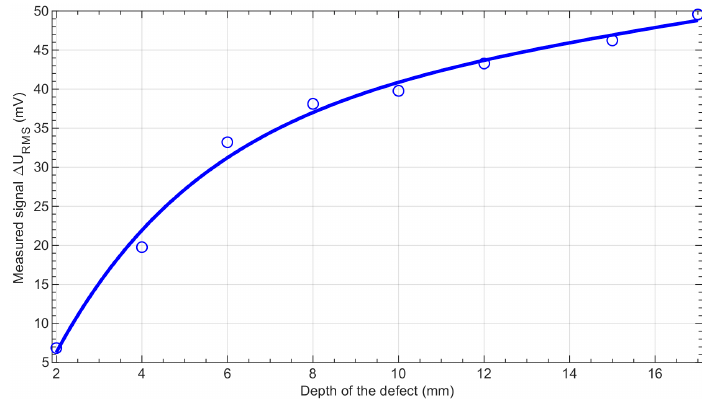
Figure 8. Maximum values of the signals measured for the aluminum samples with defects having different depths (solid line—approximation curve, circles—exact measured values).